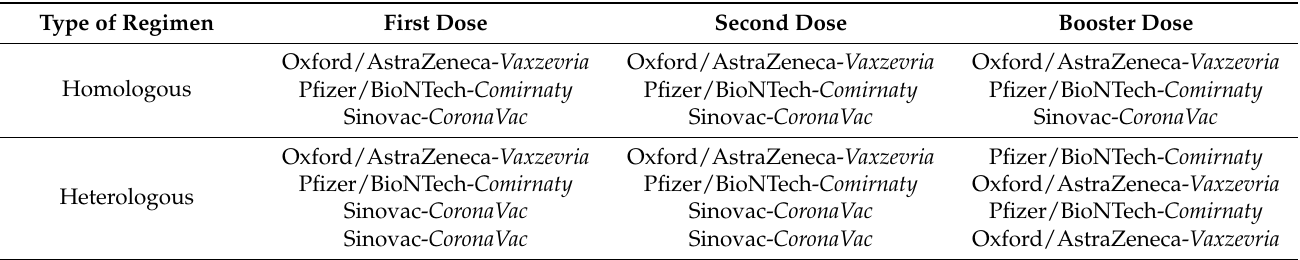
Table A1 descriptive characteristics of adverse events in relation to the dose and vaccine. Table A1. Definition of the homologous and heterologous COVID-19 vaccine regimes.